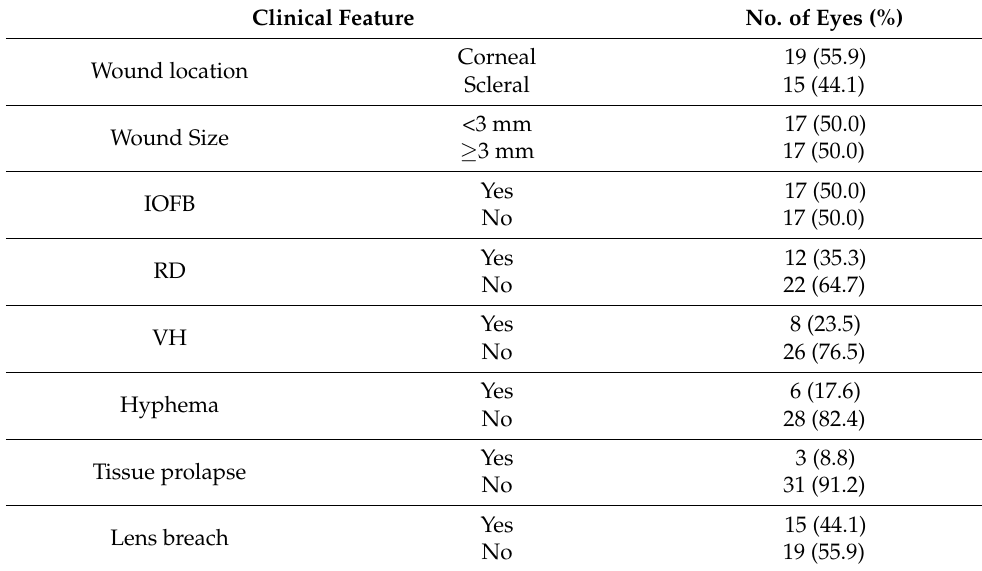
Table 4. Clinical features of patients with traumatic